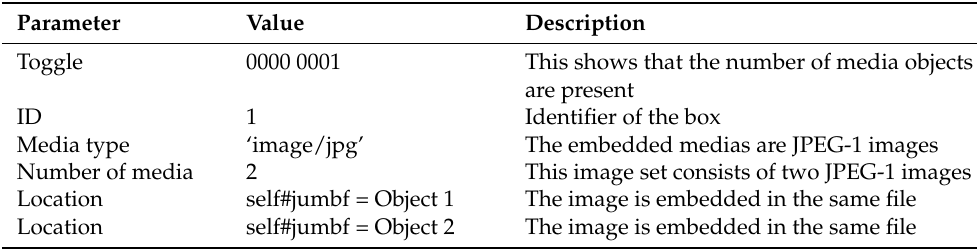
Table A7. Values of the first OBMB parameters.